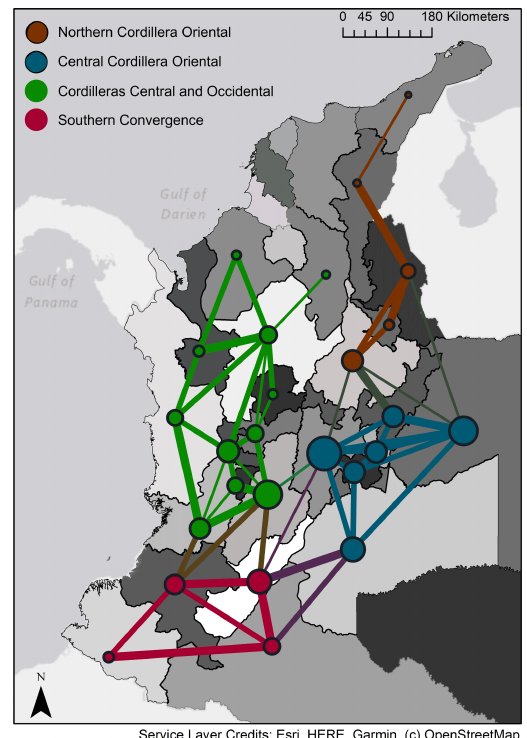
Fig. 3 . Ecological network across the Colombian Andes based upon probable Andean bear ( Tremarctos ornatus ) movement given the distribution of habitat critical to Andean bear connectivity across jurisdictional boundaries. Jurisdictions of each of the autonomous regional corporations ( corporaciones autonomas regionales [CARs]) are delineated; each CAR is represented by a circle. CARs that shared habitat critical to Andean bear connectivity are connected by lines; increasing line width is associated with more shared habitat and thus a stronger ecological connection in the network. Node sizes are indicative of relative ecological degree centrality of each CAR. Colors are indicative of four “ecoregions” detected with modularity